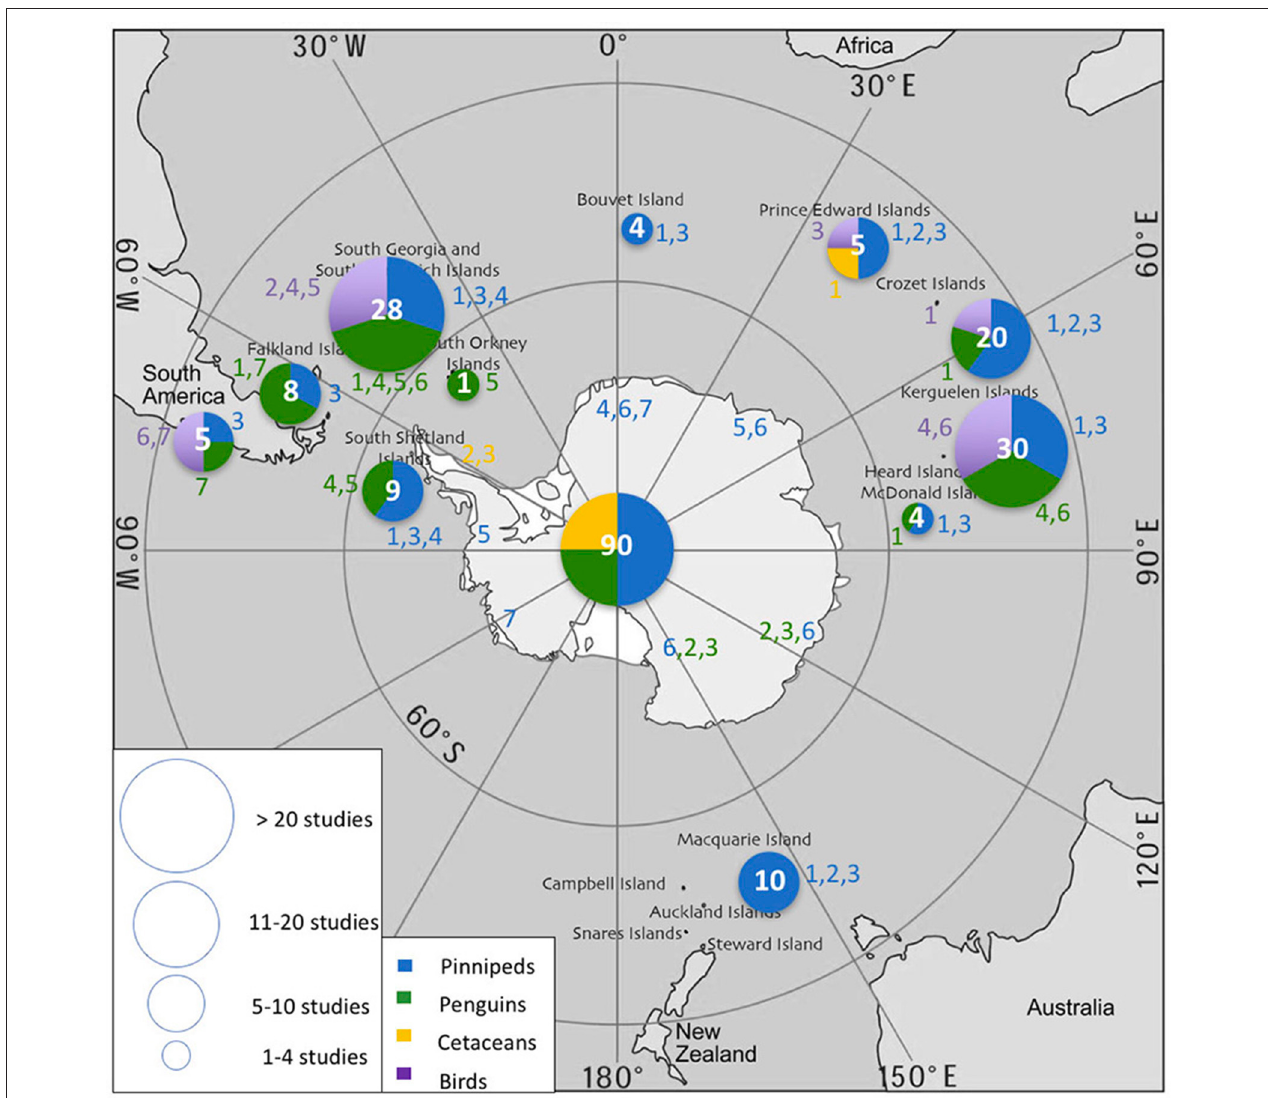
FIGURE 2 | Spatial distribution of sampling effort/data logger deployment in the Southern Ocean during 2006–2016 for each species. Circle size and white number represent the total number of studies carried out in each location. Color-coded numbers correspond to the species cited in Table 2 . The database containing all literature references is made available under Supplementary Material